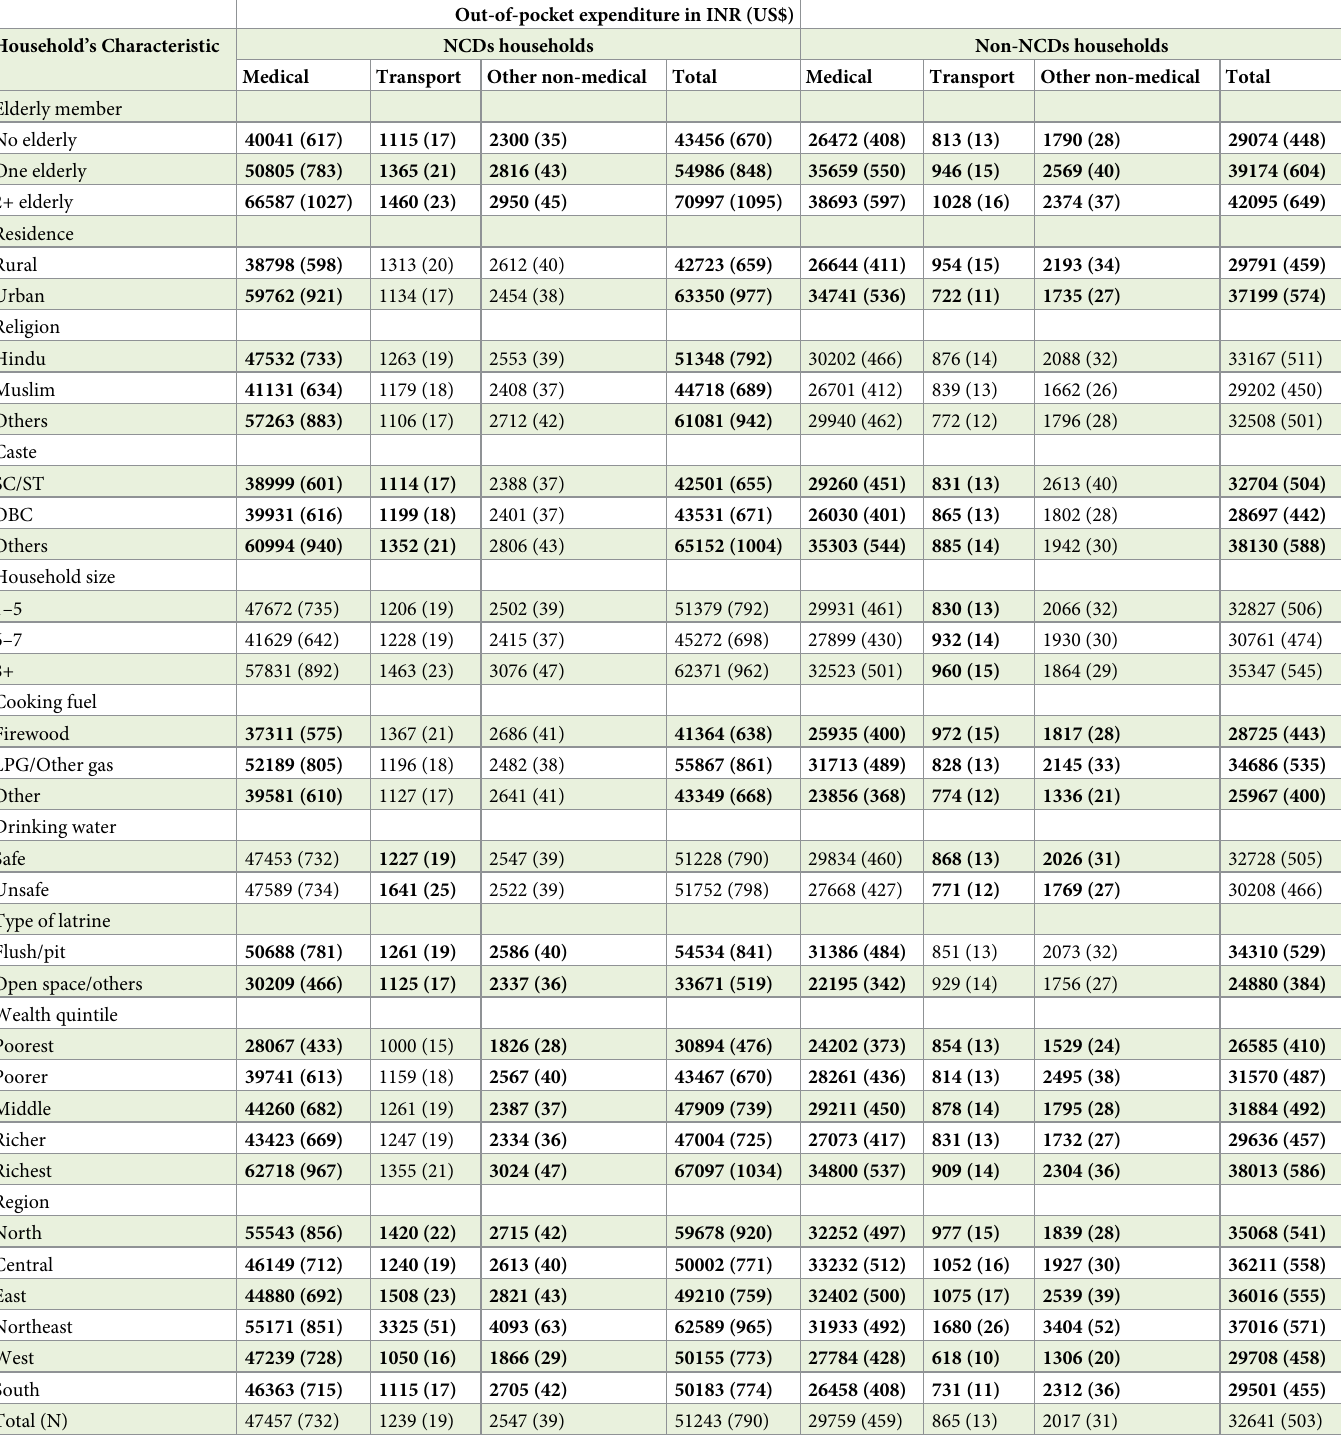
Table 3. Mean out-of-pocket expenditure by NCDs and non-NCDs households in private health care facilities, NSSO survey